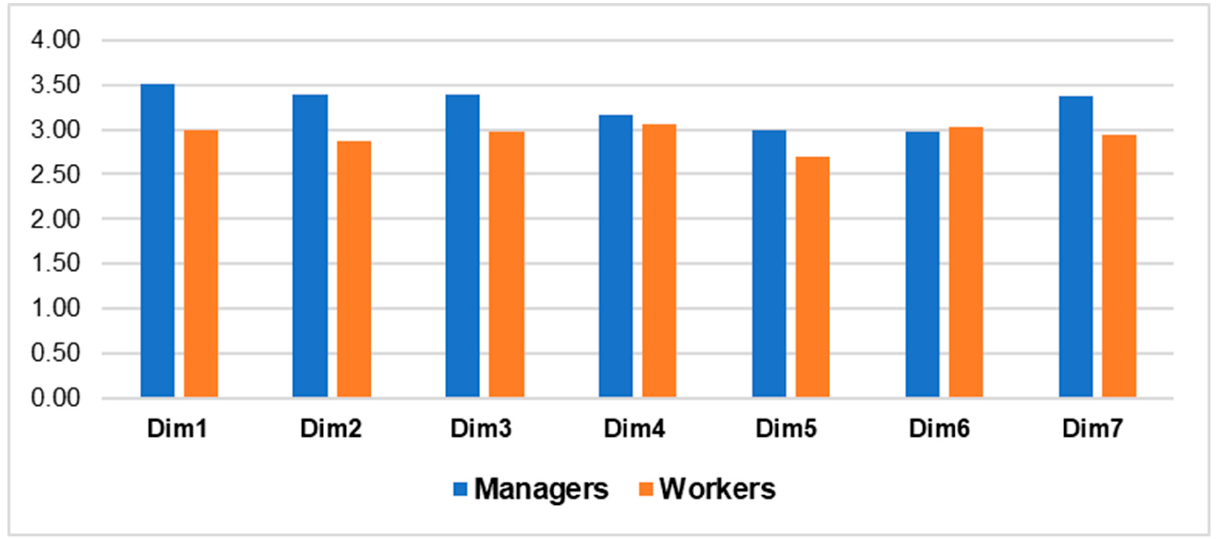
Figure 4. Scores of NOSACQ-50 divided per dimensions (mean values) achieved by managers and workers.